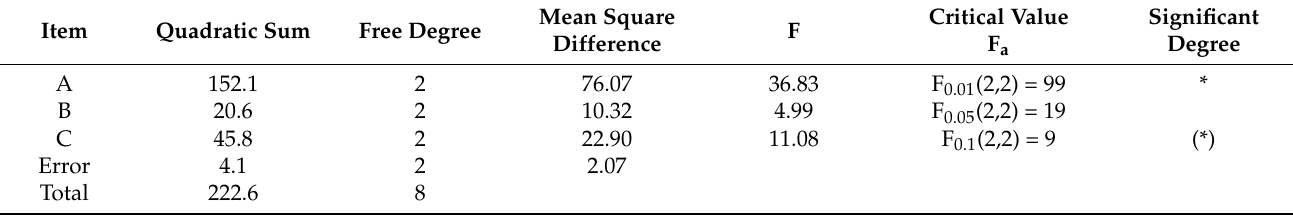
Table 6. The variance analysis of 28-day compressive